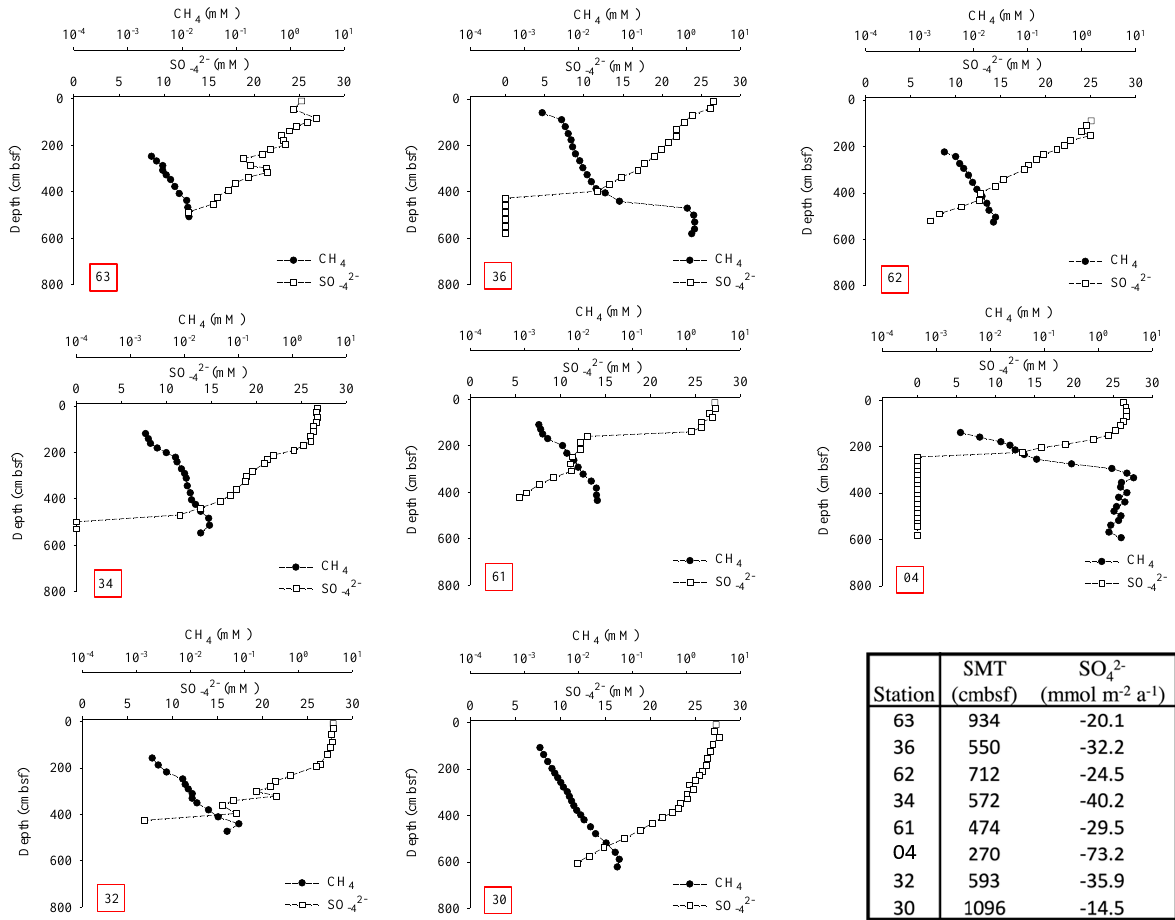
Figure 5. Geochemical data from Mahia Transect 1. Piston core numbers presented in seismic profile (Figure 4) are indicated in red boxes. See Figure 1b for geographical locations and Figure 4 for locations on TOPAS and seismic data. Geochemical data include sediment CH 4 and porewater SO 42 − concentrations. “cmbsf” = cm below seafloor. Table in lower right shows the sulfate – methane tran- sition zone (SMT), determined from the SO 42- concentrations. For Mahia Transect 2, as in Mahia Transect 1, we used high-amplitude reflections in seismic data marking shallow gas occurrence, as well as near-seafloor faults in TOPAS data, indicating potential fluid-migration paths, to select piston core sites (Figure 6). Through the seismic and TOPAS profiles there was a moderate indication of vertical fluid and gas mi- gration upslope and downslope across a mound (Figure 6). Again, these seismic profiles corroborated geochemistry data, and profiles for this region showed a similar pattern across Sites 39, 57 and 43 with a range in SMT of 238 to 405 cmbsf and vertical fluid and gas migra- tion of − 47.5 to − 69.8 mmol m − 2 a − 1 (Figure 7). With further review of seismic data, we do observe an indication of elevated fluid and gas migration at Core 37 with an SMT of 366 cmbsf and fluid and gas migration of − 37.0 mmol m − 2 a − 1 . Comparison of Mahia Transects 1 and 2 suggests moderately higher vertical CH 4 migration across Mahia Transect 2 with an average of 551 cmbsf relative to 650 cmbsf for Mahia Transect 1. While seismic and geo- chemistry profiles at Mahia Transects 1 and 2, this correlation is not observed at the control site.